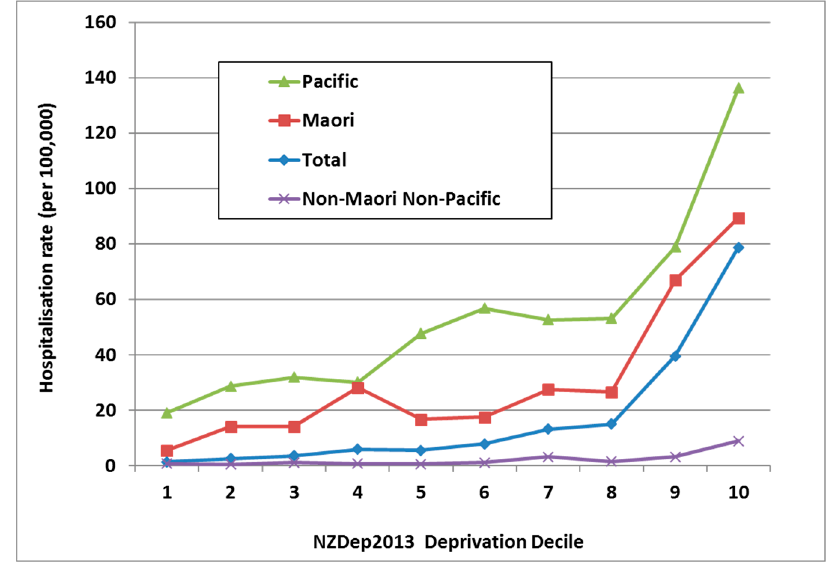
Figure 6. ARF incidence by prioritised ethnicity and deprivation level, initial hospitalisation rate per 100,000, 5–14 year olds, average for 2010–2014.